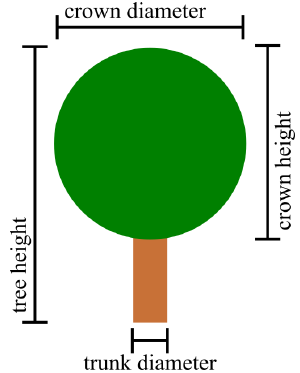
Figure 13. Schematic view of the parameters for a spherical tree shape through which the three-dimensional structure of trees is con- structed in the single-tree canopy generator.